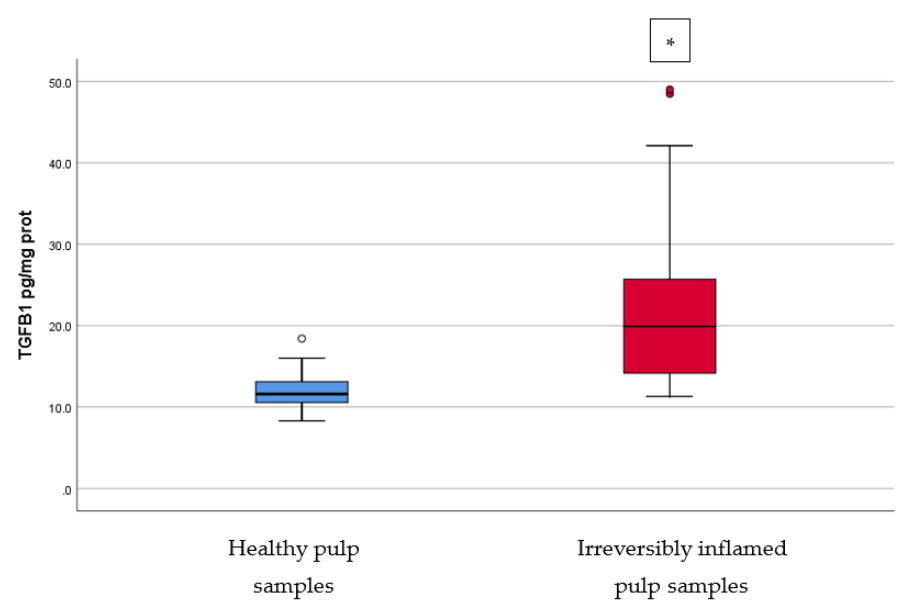
Figure 6. Comparison of TGF- β 1 levels (pg/mg protein) in healthy and irreversibly inflamed dental pulp samples, respectively. The distribution of variables is non-parametric in the irreversibly inflamed pulp samples group according to the Shapiro–Wilk test ( p = 0.001). Mann–Whitney’s U test shows that the differences between the two groups are statistically significant ( p < 0.001). (* indicates a statistically significant difference).